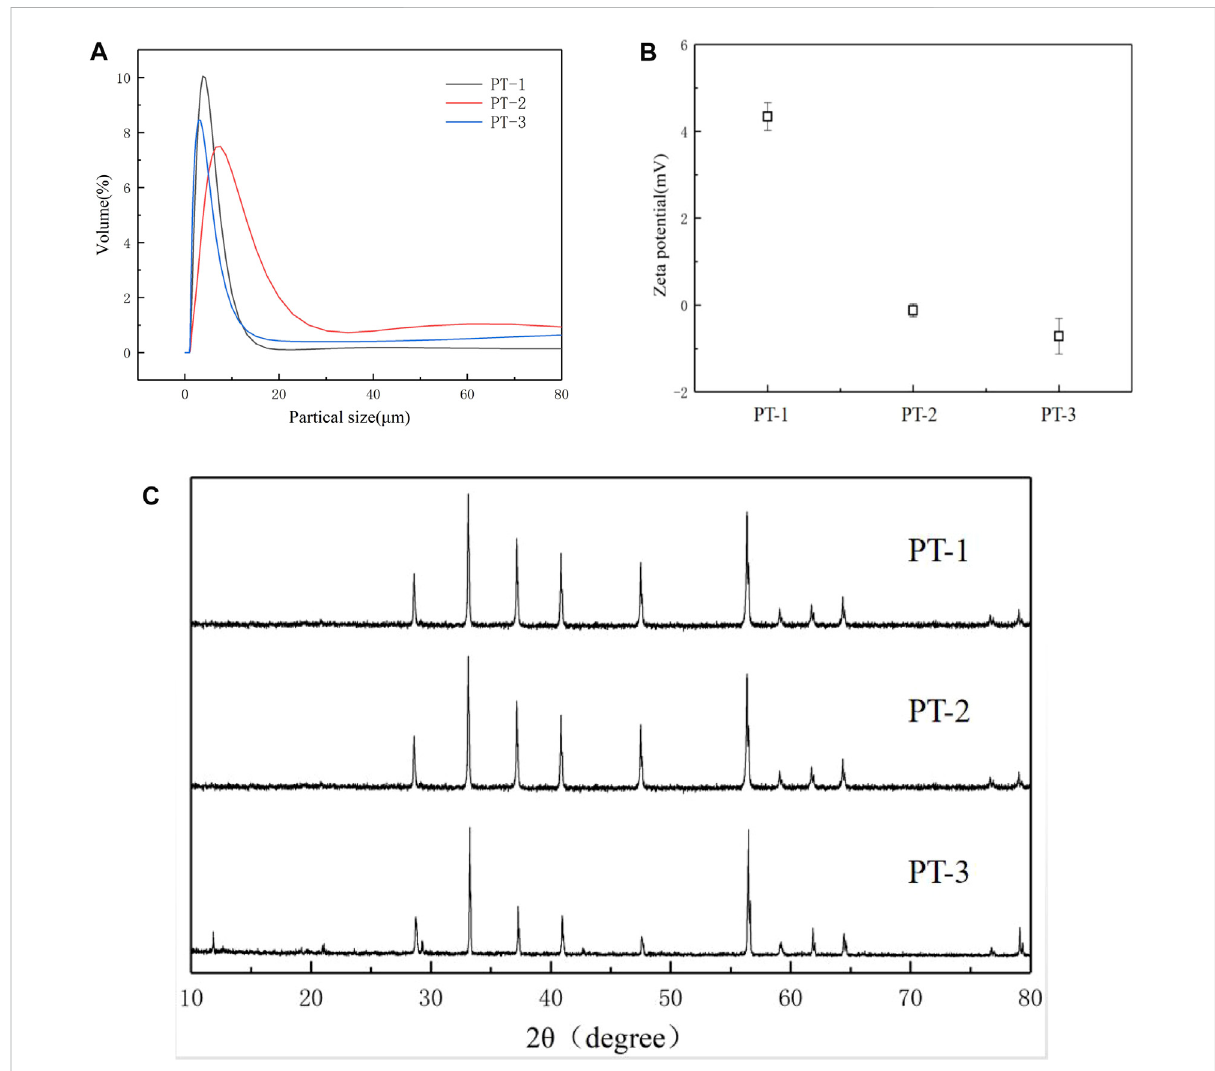
FIGURE 4 Particle size distribution spectrum (A) and XRD spectrum (B), Zeta potential (C) of pyrite tailings with different